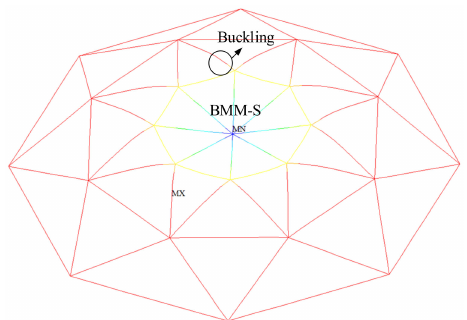
Figure 30. Failure mode of reticulated shell after setting